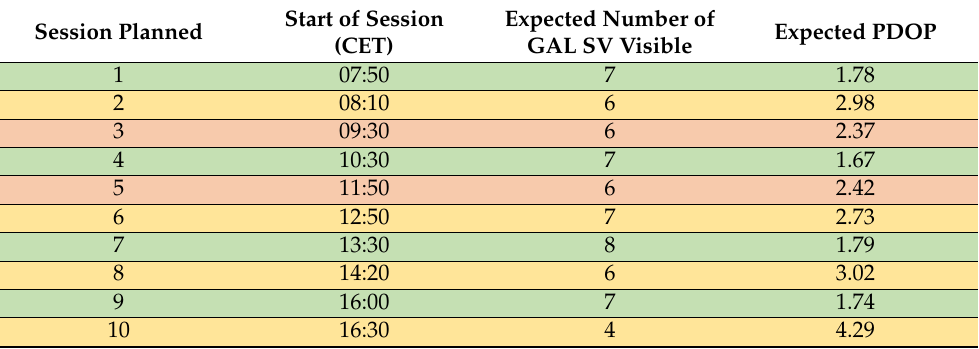
Figure 1. Sky Plot (Trimble Planning) of the station A (Zagreb, Croatia) for the time window 06:00– 18:00 CET (14 July 2020) considering the local horizon and Galileo satellites only. The cyan area shows the open sky where the satellites’ signals come from. Each satellite’s track is marked by the GAL satellite it belongs to (e.g., E33); on each track are marked the positions planned for the full-hour epochs (e.g., 11, 12 . . . 18). Table 1. Sessions planned according to the visibility of GAL satellites and expected PDOP values. Those having good, medium, and bad observation conditions are marked in green, orange, and yellow color,